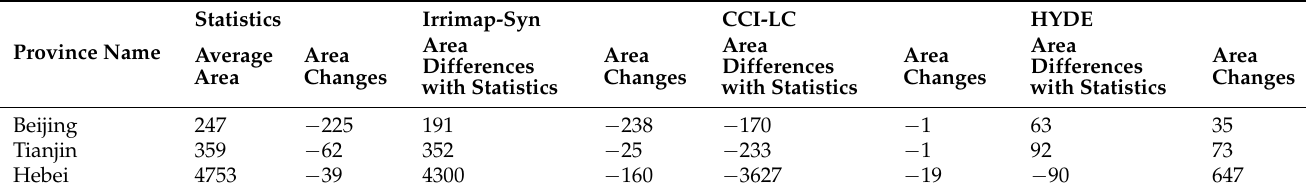
Table A1. Area differences with statistics in average and irrigated area changes of Irrimap-Syn, CCI-LC, and HYDE at a provincial level from 2000 to